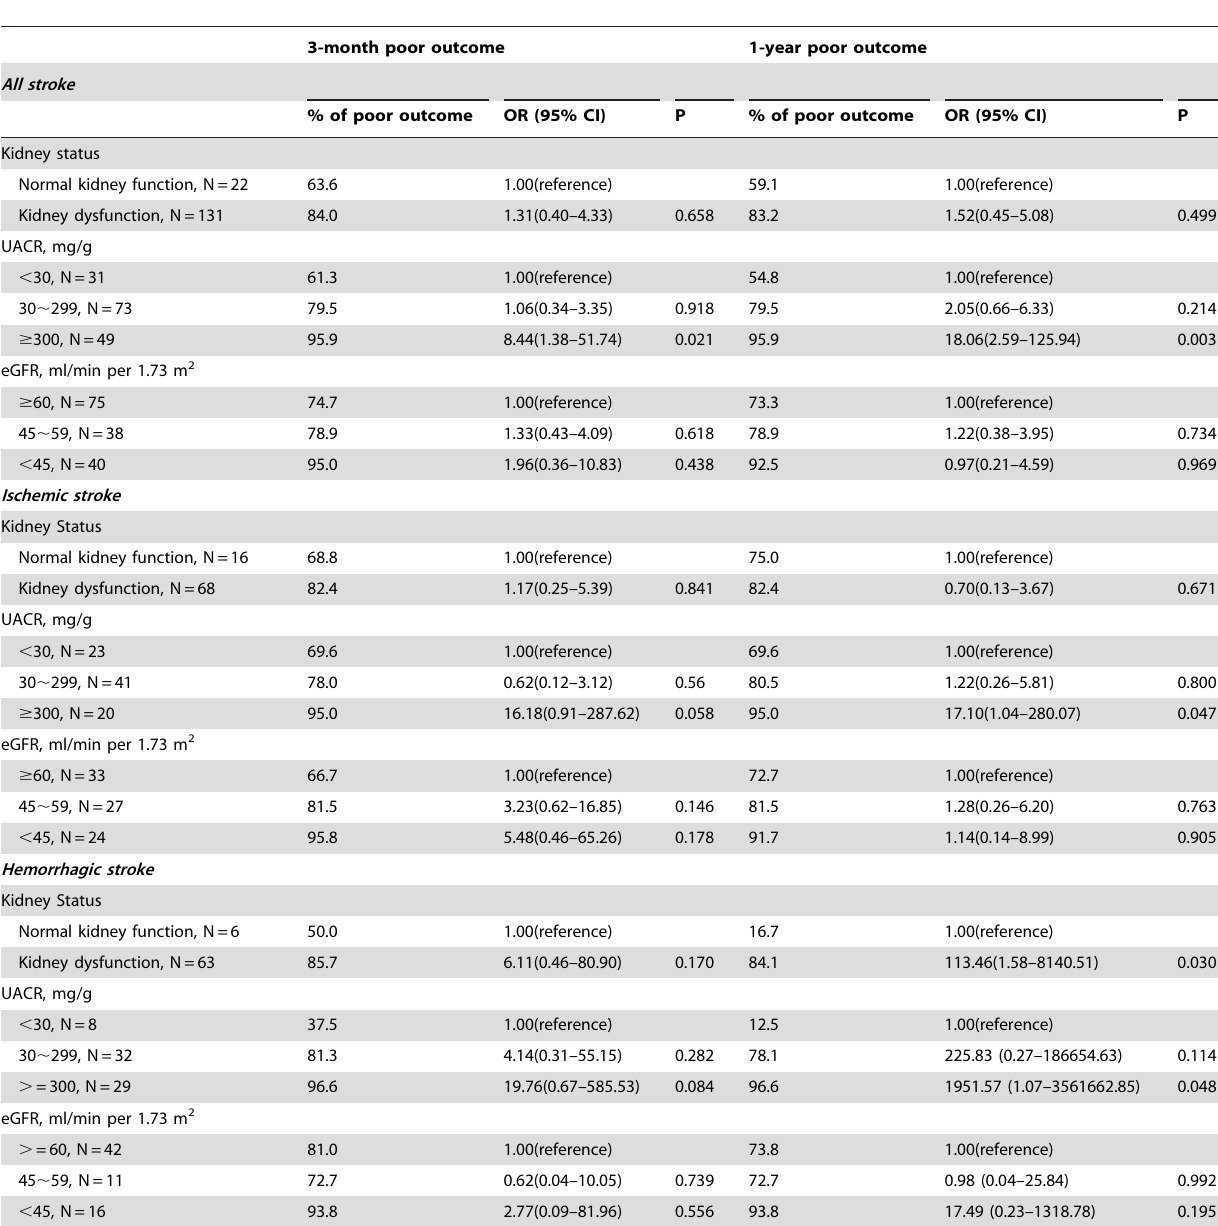
Table 3. The relationship between baseline subcategories of UACR or eGFR and poor outcome (modified Rankin Scale 3–6) after